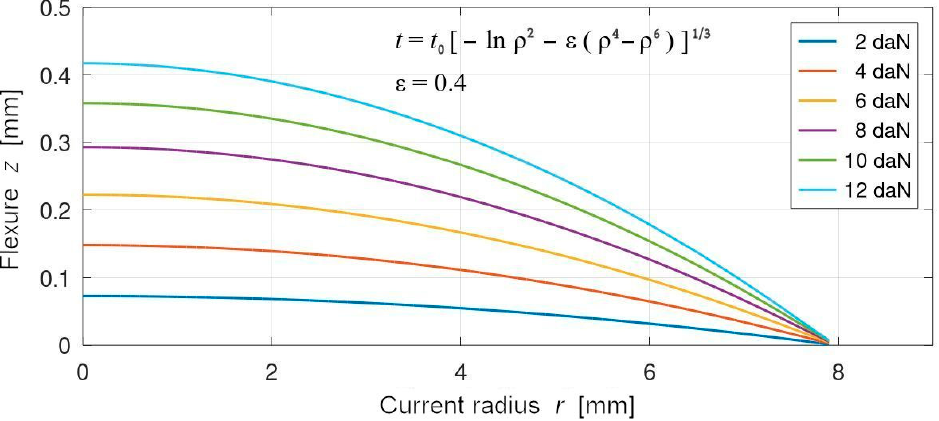
Figure 10. Flexure amplitude vs. current radius for central forces in the range intensity 2–12 daN over 16 mm full diameter. The flexural sag is 418 μ m for F = 12 daN and 355 μ m for F = 10 daN. Table 1. Thickness t ( r ) of tulip-like VCM from Nastran modeling. Truncated center thickness t c = 618 µ m for r < 0.4 mm. t 0 = 300 µ m. Radial thickness of outer cylinder collarette 20 µ m. Thickness t *( r ) is t ( r ) + 10 µ m constant over-thickness for CNC lathe